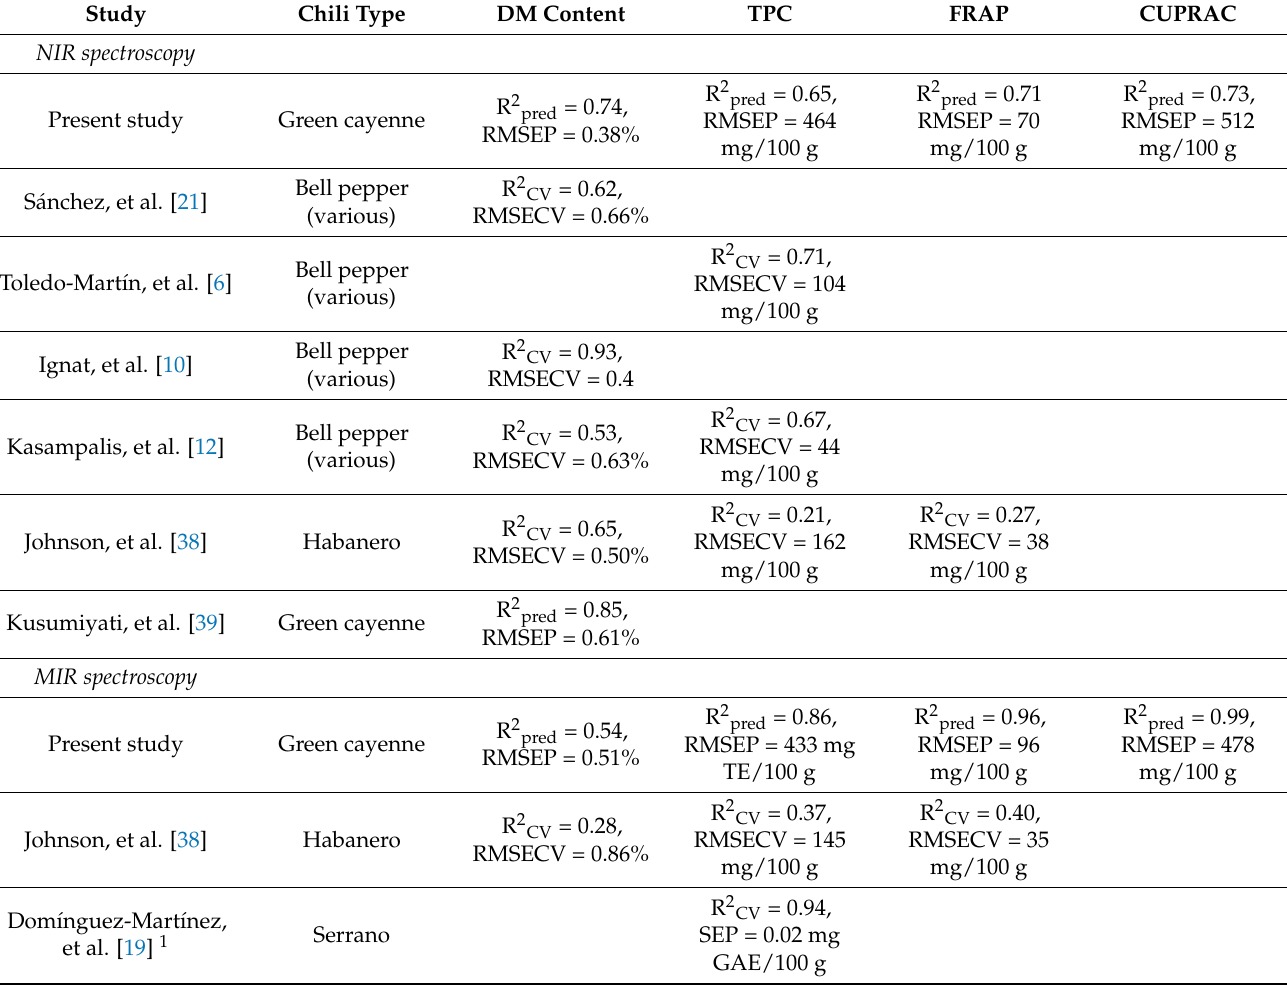
Table 6. Summary of the results for the prediction of DM, TP, FRAP, and CUPRAC content in green cayenne pepper and their comparison to previous studies on other chili varieties. Note: R 2 pred and RMSEP values are provided where reported; R 2 CV and RMSECV values are provided where a test set was not